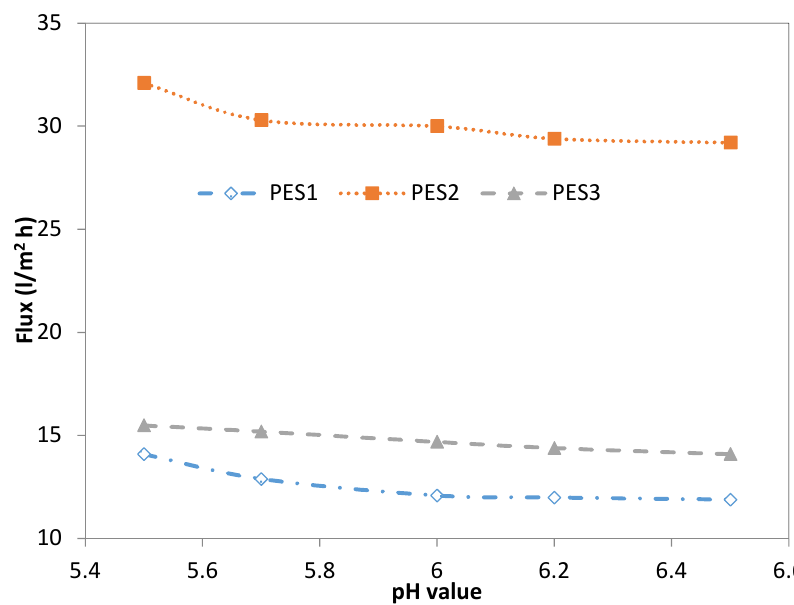
Figure 3. E ff ect of feed pH value on final permeate flux of PES1, PES2, and PES3 membranes for Pb 2 + (experimental conditions: Pb 2 + concentration of 100 ppm, transmembrane pressure of 1 bar).